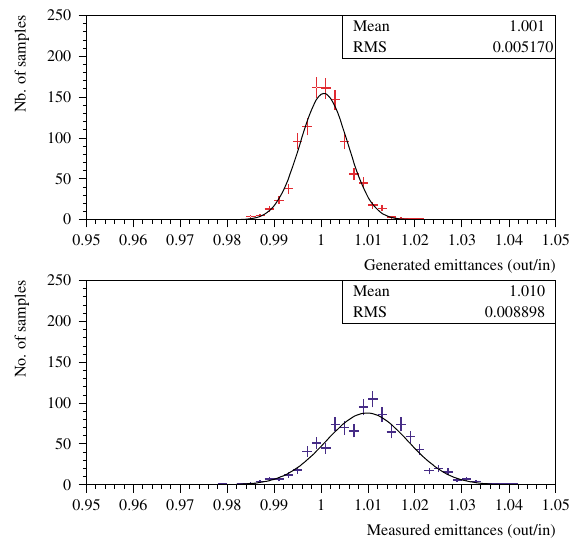
FIG. 49. (Color) Distribution of ratios of output to input 6-dimensional emittance for 1000 simulated experiments, each with 1000 accepted muons. The top figure shows the distribution of this ratio for the emittances as generated by simulation; the bottom figure, as ‘‘measured’’ in the simulated experiments. The curves are Gaussian fits to the